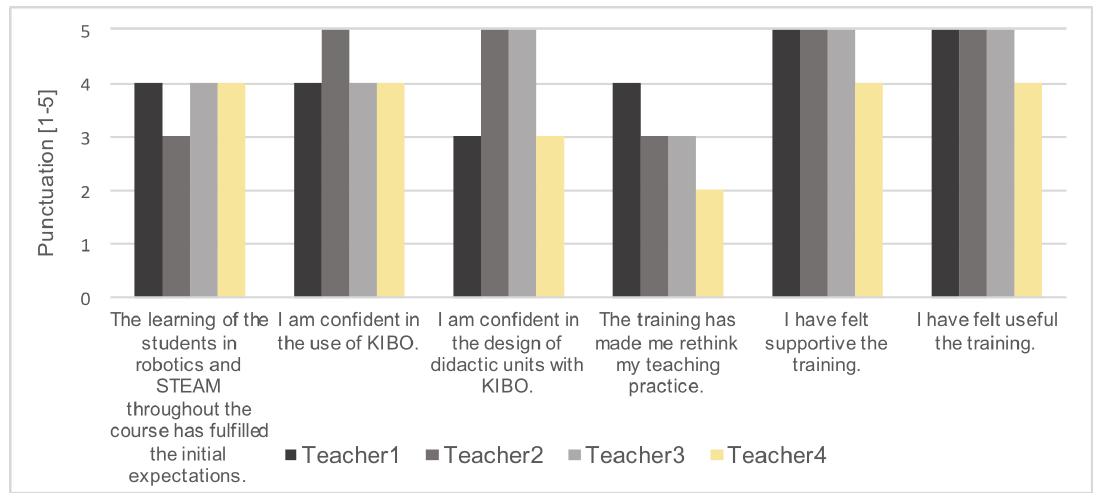
Figure 3. Results of the final questionnaire, where each of the statements presented was scored from 1 to